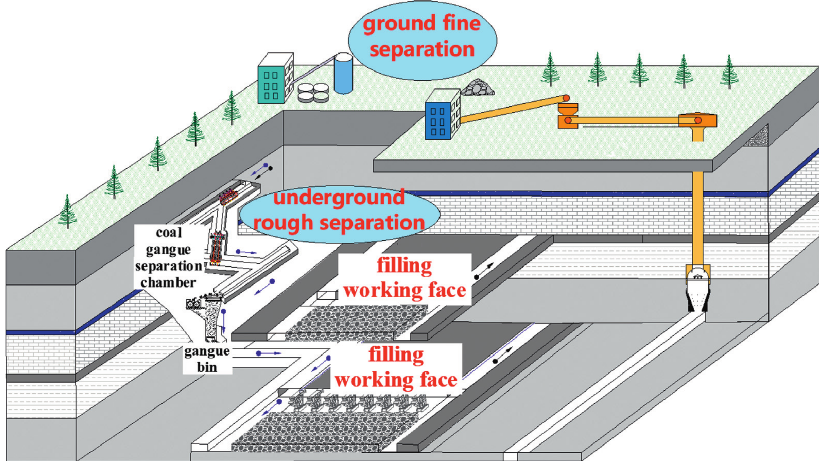
Figure 4: Basic concept of solid fill mining.